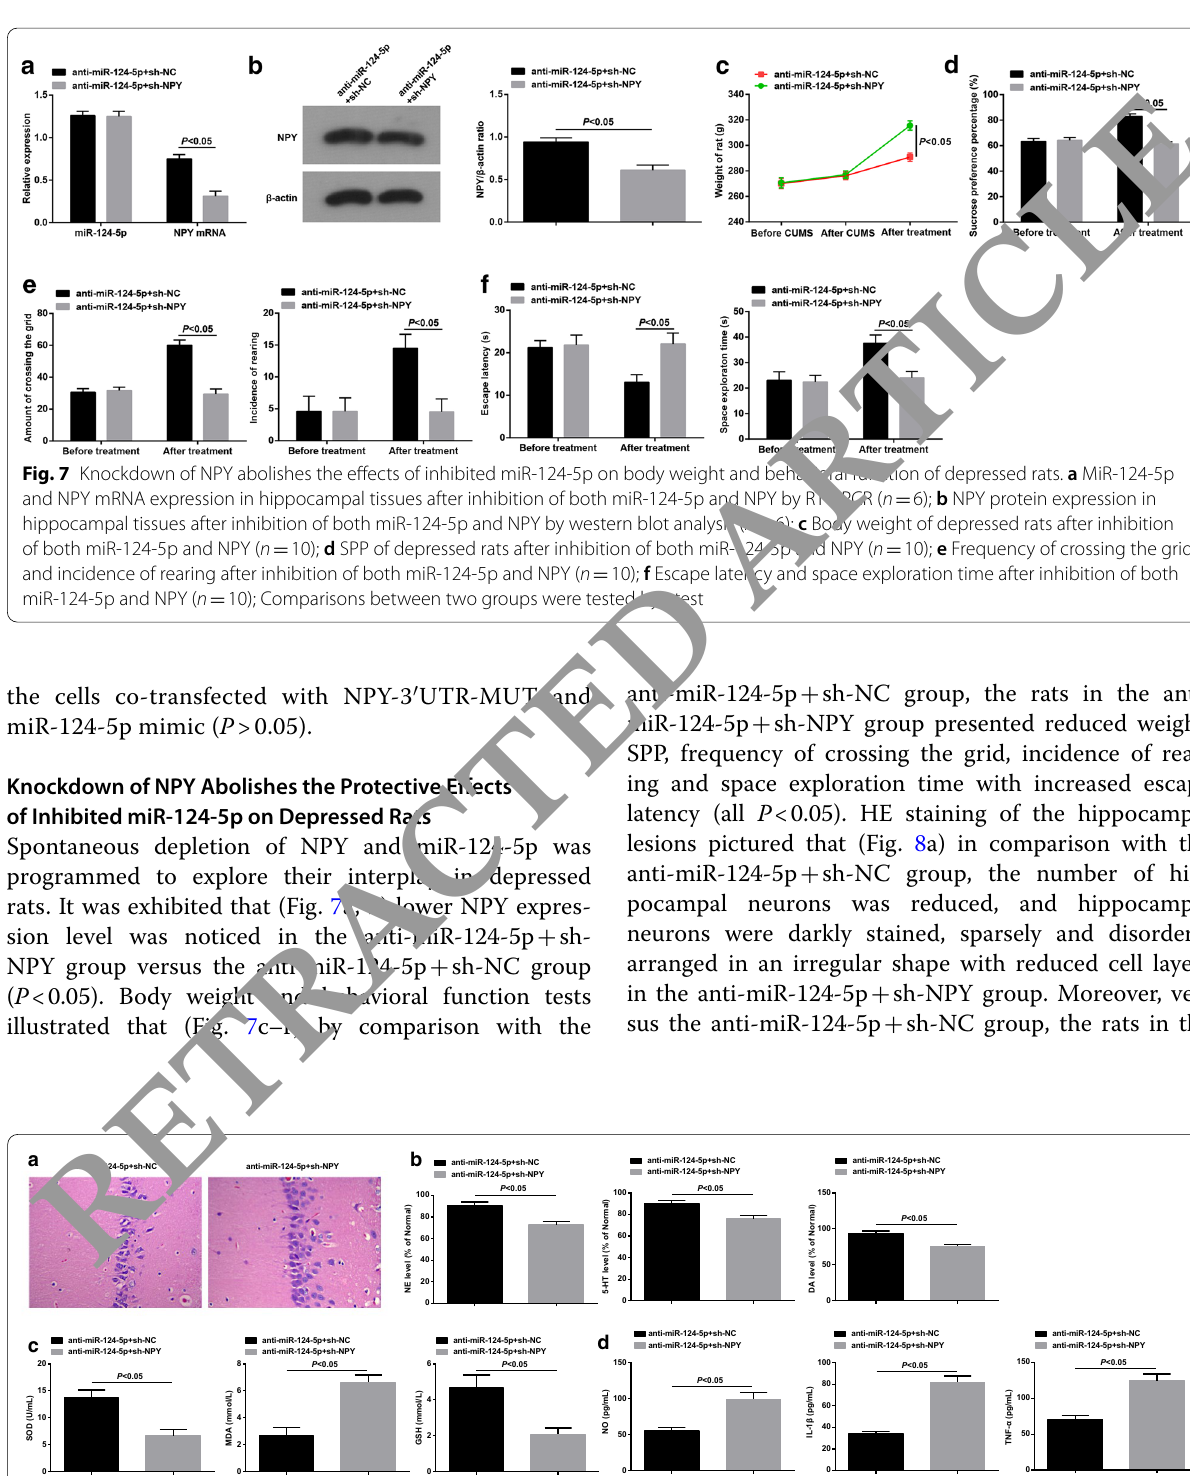
Fig. 8 Knockdown of NPY abolishes the effects of inhibited miR-124-5p on hippocampal damages of depressed rats. a HE staining of hippocampal lesions of rats after inhibition of both miR-124-5p and NPY ( n 6); b ELISA of NE, 5-HT and DA expression in hippocampal tissues of rats after = inhibition of both miR-124-5p and NPY ( n 6); C. Effect of inhibited NPY and suppressed miR-124-5p on SOD, MDA and GSH concentration in serum = ( n 10); D. Effect of inhibited NPY and suppressed miR-124-5p on IL-1β, TNF-α and NO concentration in serum ( n = groups were tested by t